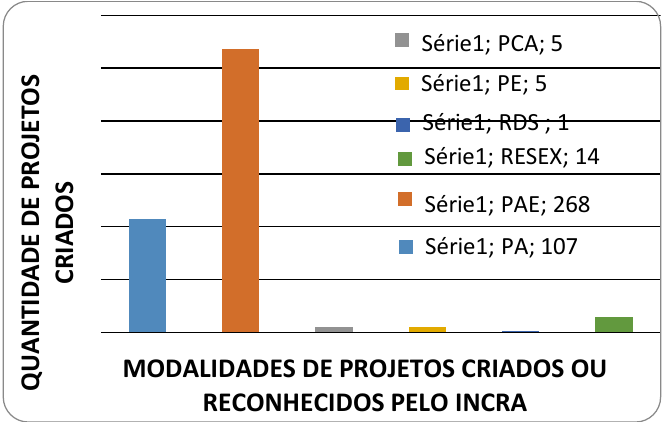
Figura 1: Gráfico - Quantitativo atual de projetos criados e∕ou com famílias beneficiárias pelo INCRA SR-01